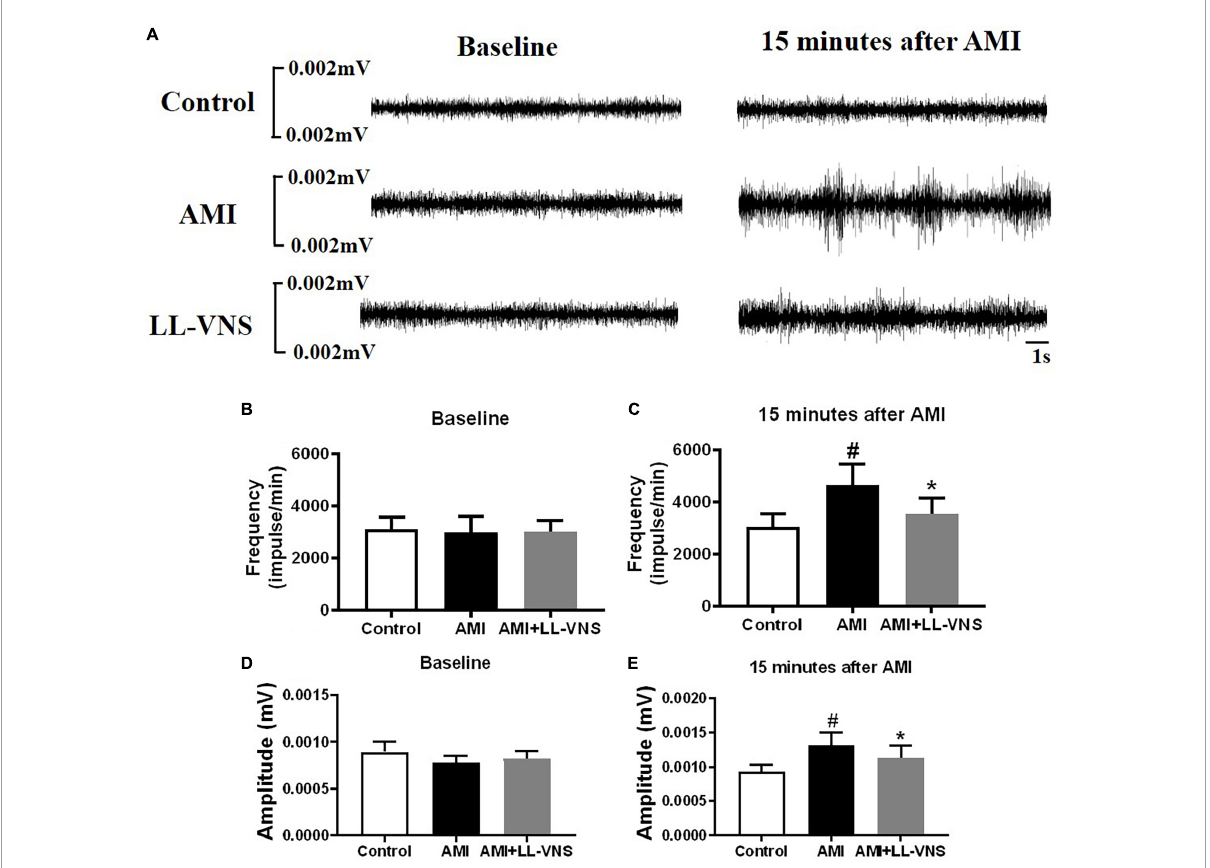
FIGURE3 Effects of LL-VNS on neural activity in the left stellate ganglion (LSG). (A) Representative examples of LSG neural activity in the Control group, AMI group, and AMI + LL-VNS group. (B–E) Quantitative analysis of LSG neural activity in the three groups. LL-VNS significantly mitigated the AMI-induced increases in amplitude and frequency of LSG neural activity. AMI, acute myocardial infarction; LL-VNS, low-level vagus nerve stimulation. n = 15 per group. # P < 0.05 in a comparison with the Control group. * P < 0.05 in a comparison with the AMI group.